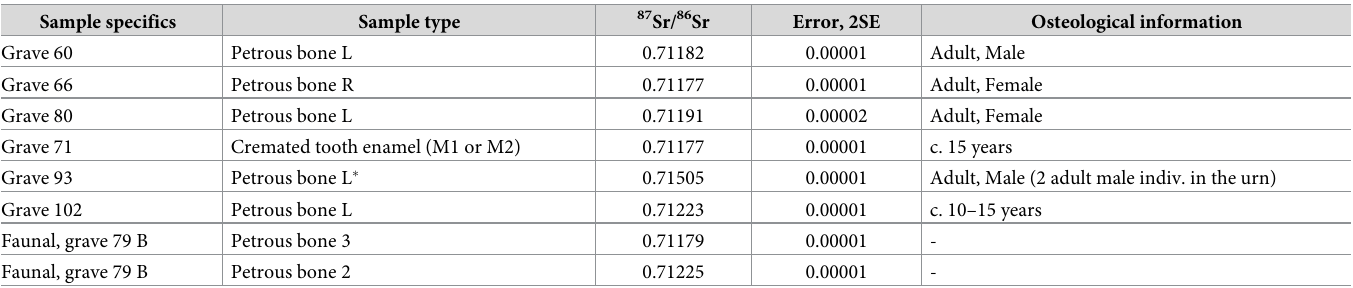
Table 1. Strontium isotope ratios of human and faunal remains of the Simris II